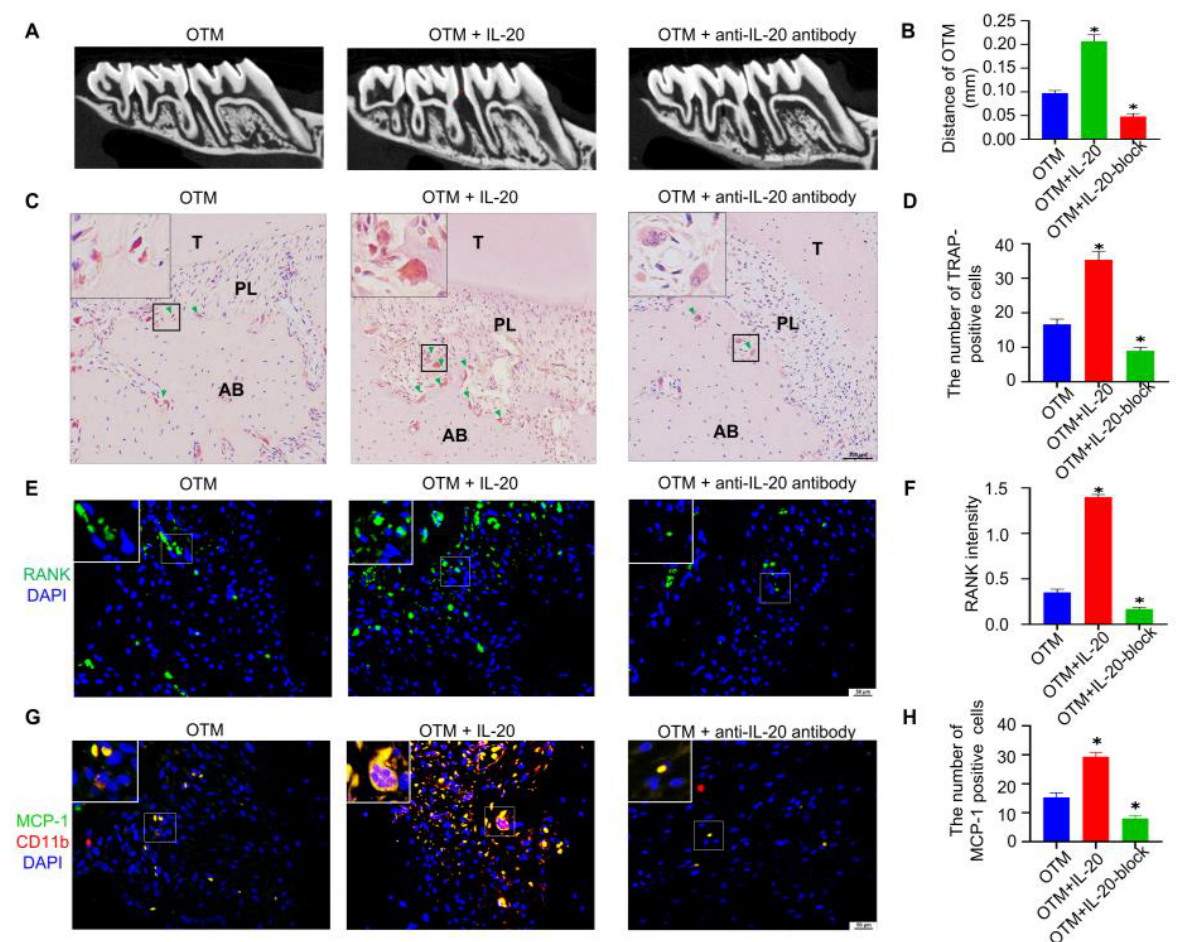
Figure 6. Therapeutic effect of IL-20 on orthodontic tooth movement. ( A , B ) Micro-CT showed the distance of orthodontic tooth movement between first and second molars treated with local infusion of IL-20 or an-ti-IL-20 antibody, seven days after the application of orthodontic force. OTM + IL- 20-block group meant that rats were locally infused with anti-IL-20 antibody. ( C , D ) TRAP staining and the quantification of TRAP-positive osteoclasts in the OTM group, OTM + IL-20 group, and OTM + anti-IL-20 antibody group. Green triangles showed TRAP-positive osteoclasts. OTM + IL-20- block group meant that rats were locally infused with anti-IL-20 antibody. ( E , F ) Immunofluorescence staining showed that the expression levels of osteoclast marker protein RANK in the first molar periodontal ligament after the application of orthodontic force. OTM + IL-20-block group